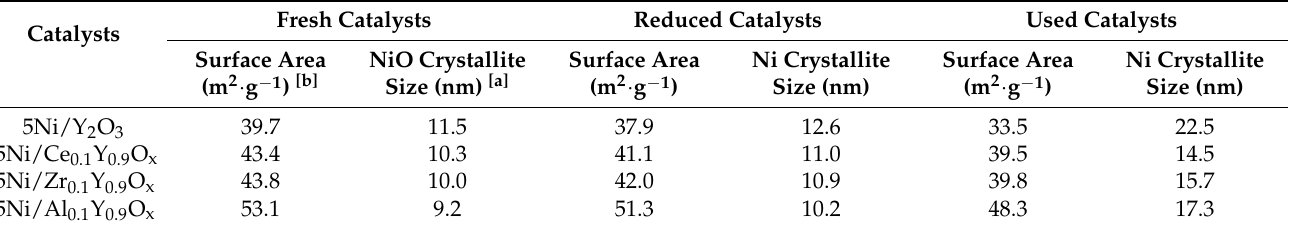
Table 3. Surface areas and crystallite sizes of the catalysts before and after the reaction.